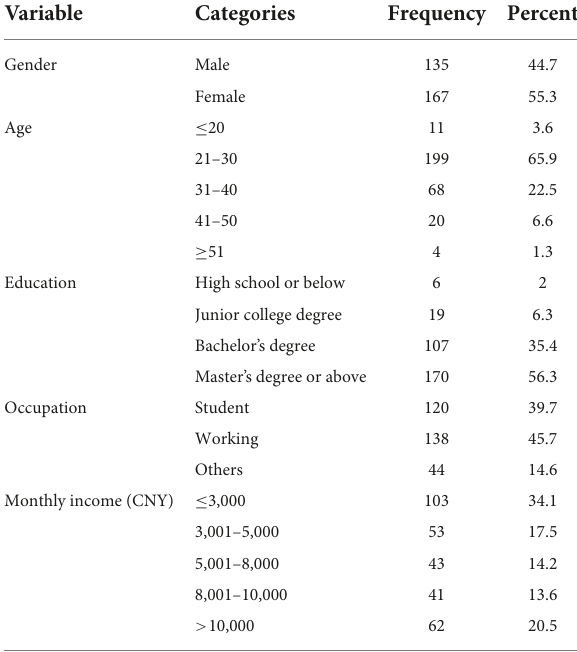
TABLE 1 Demographic characteristics of the sample.